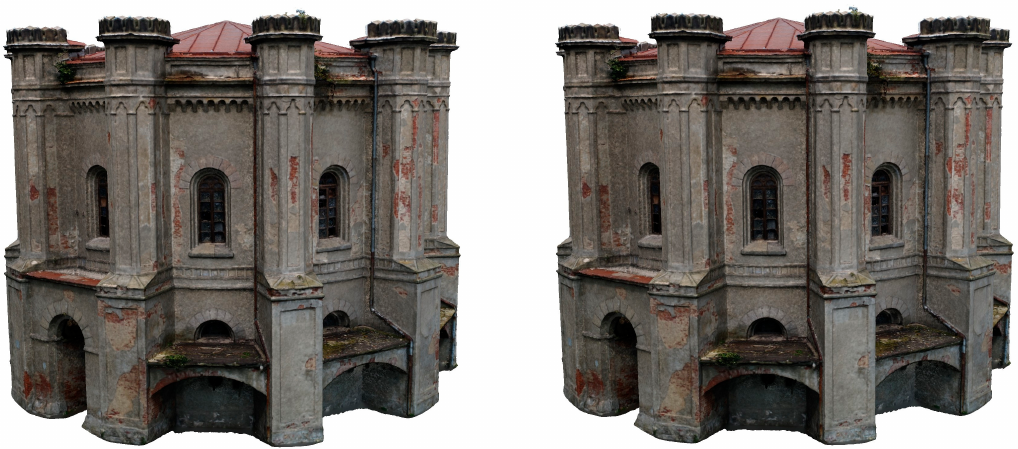
Figure 8. Visualization of UAV dense point cloud ( left ), texture shaded model ( right ).